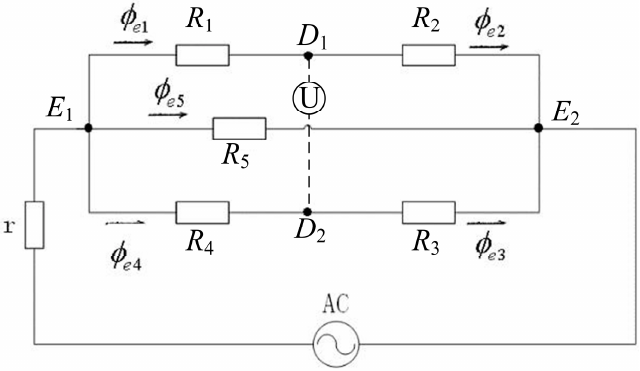
Figure 2. Schematic diagram of the sensor’s excitation magnetic equivalent circuit and magnetic flow.